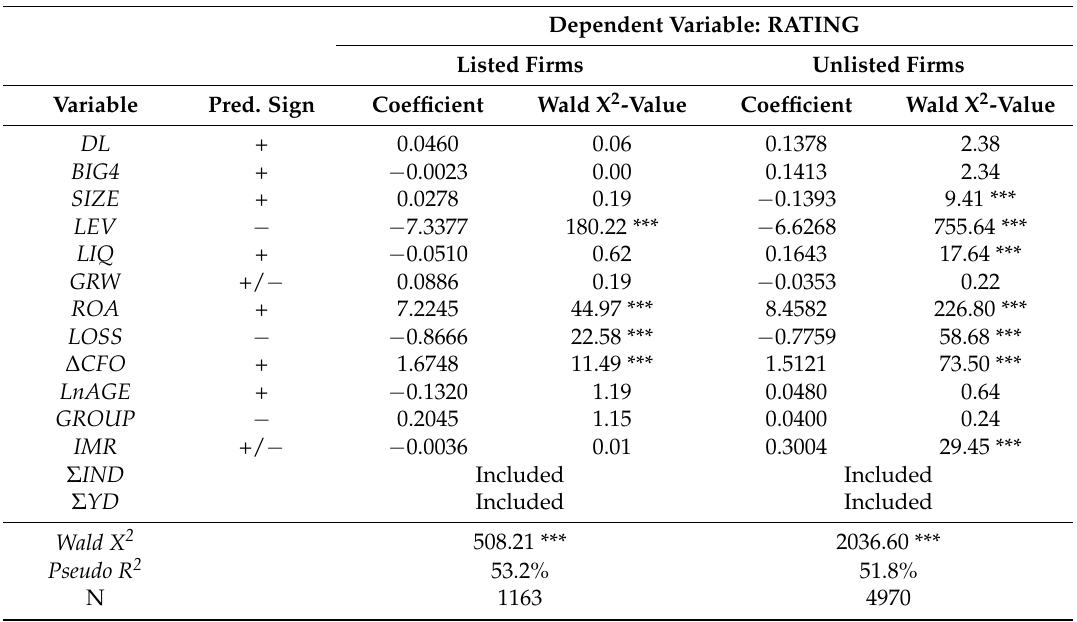
Table 7. Cluster-adjusted ordered probit regression results for